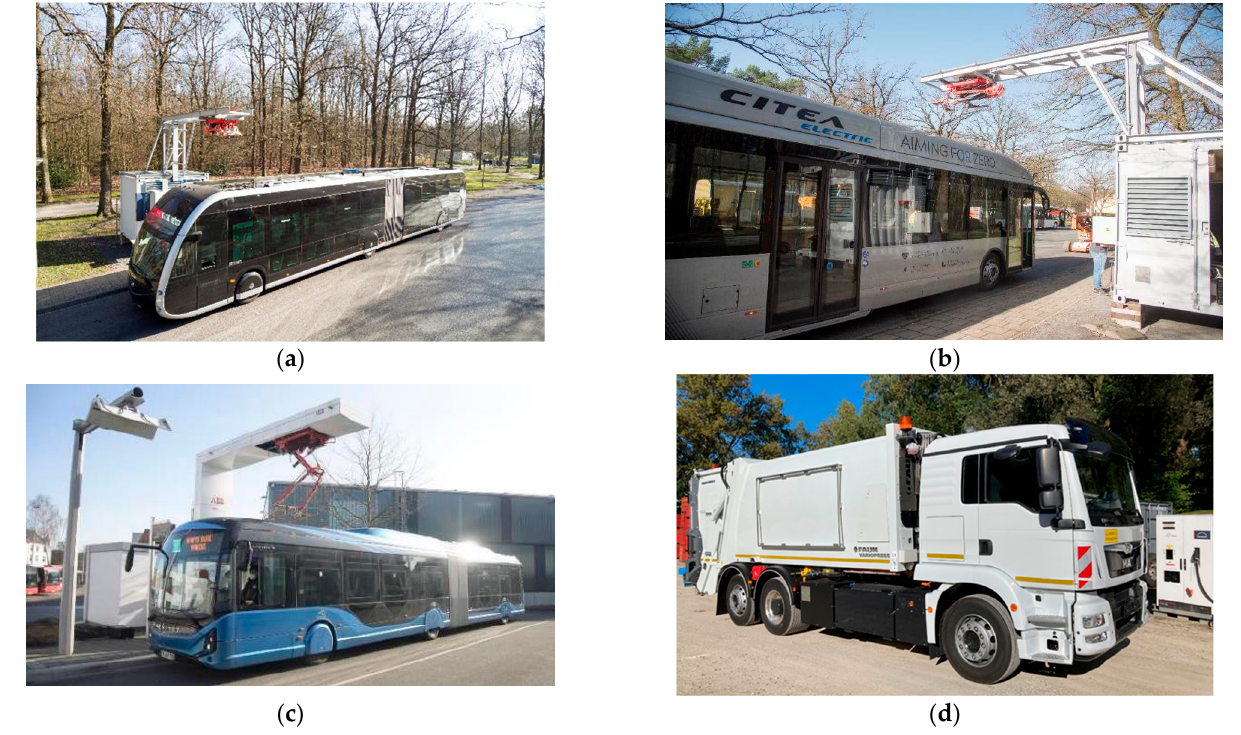
Figure 2. IRIZAR ieTram 18 m articulated EB [13] ( a ) IRIZAR ieTram 18 m articulated EB in Osnabrück at Waldfriedhof charging station, Type A, ( b ) VDL Citea SLE-129 at Waldfriedhof charging station, Type A, ( c ) Heuliez GX437E 18 m bus at SWO depot [14], ( d ) MAN refuse collection E-truck.